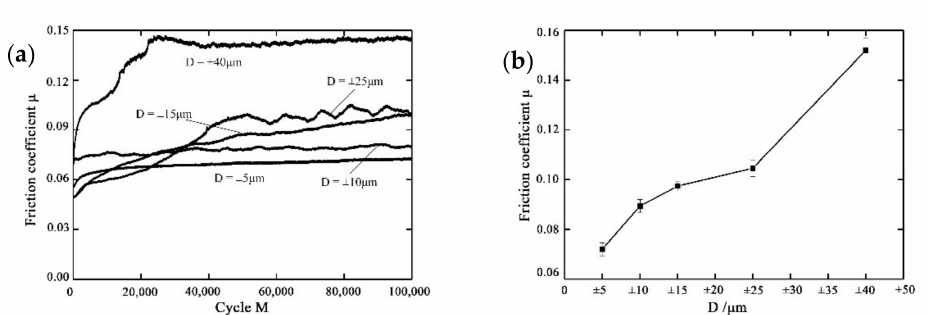
Figure 6. The effect of the displacement amplitude on the friction coefficient of PVDF thin films with F n = 15 N, ƒ = 15 Hz, and V c = 0 V: ( a ) variation with the number of cycles, ( b ) error